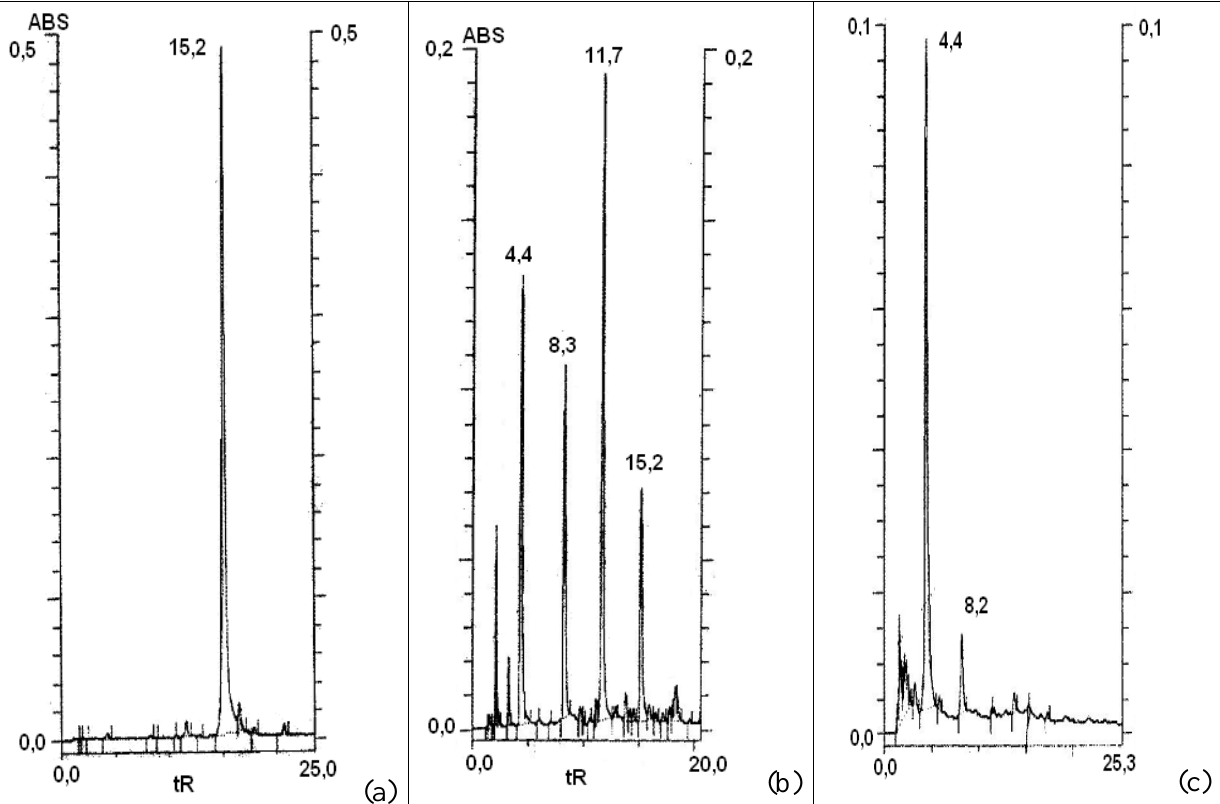
Figure 3. HPLC chromatograms (regime 1, detection wavelength 254 nm) (a) – initial solution of quercetin (t 15.2 min); (b) – the same solution after ∼ 1 h of air R bubbling at ambient temperature; (c) – the same solution after termination of the process (air bubbling during more than 3-3.5